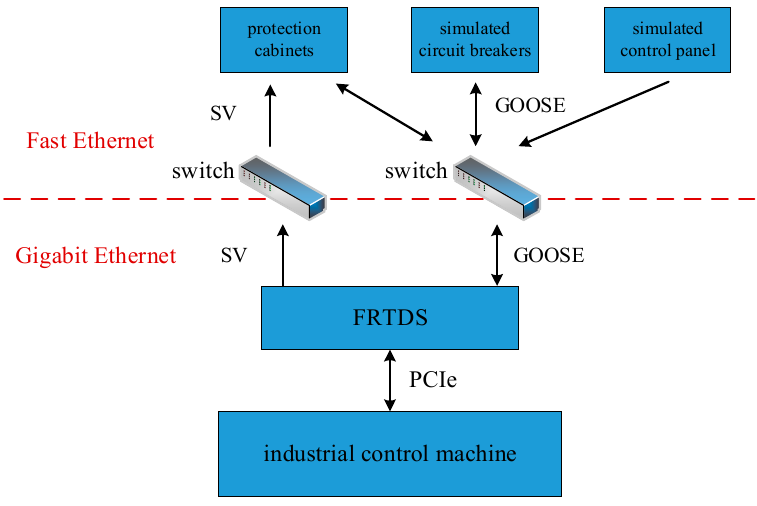
Figure 7. The overall structure of the real-time simulation platform.